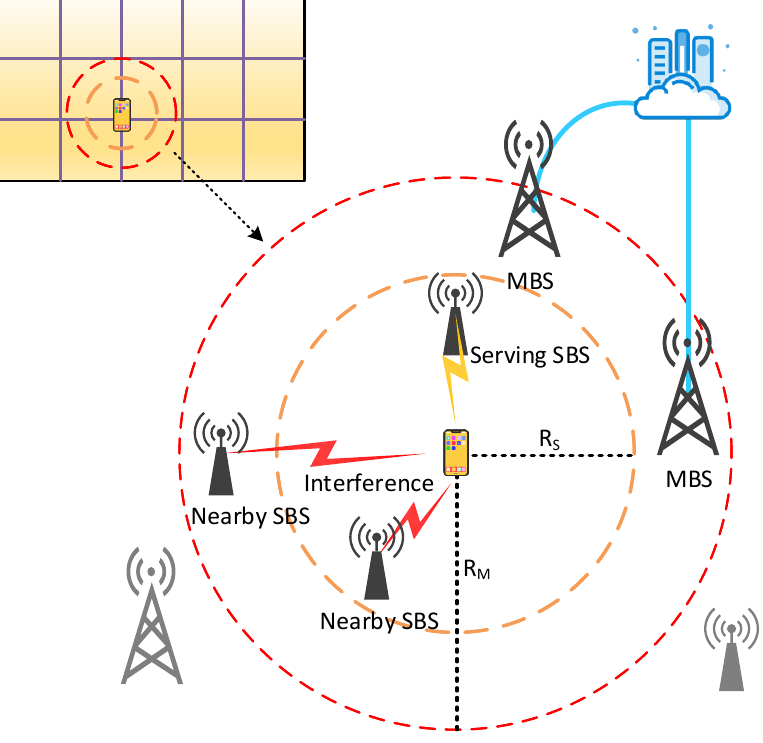
Figure 5. Cache-enabled user-centric